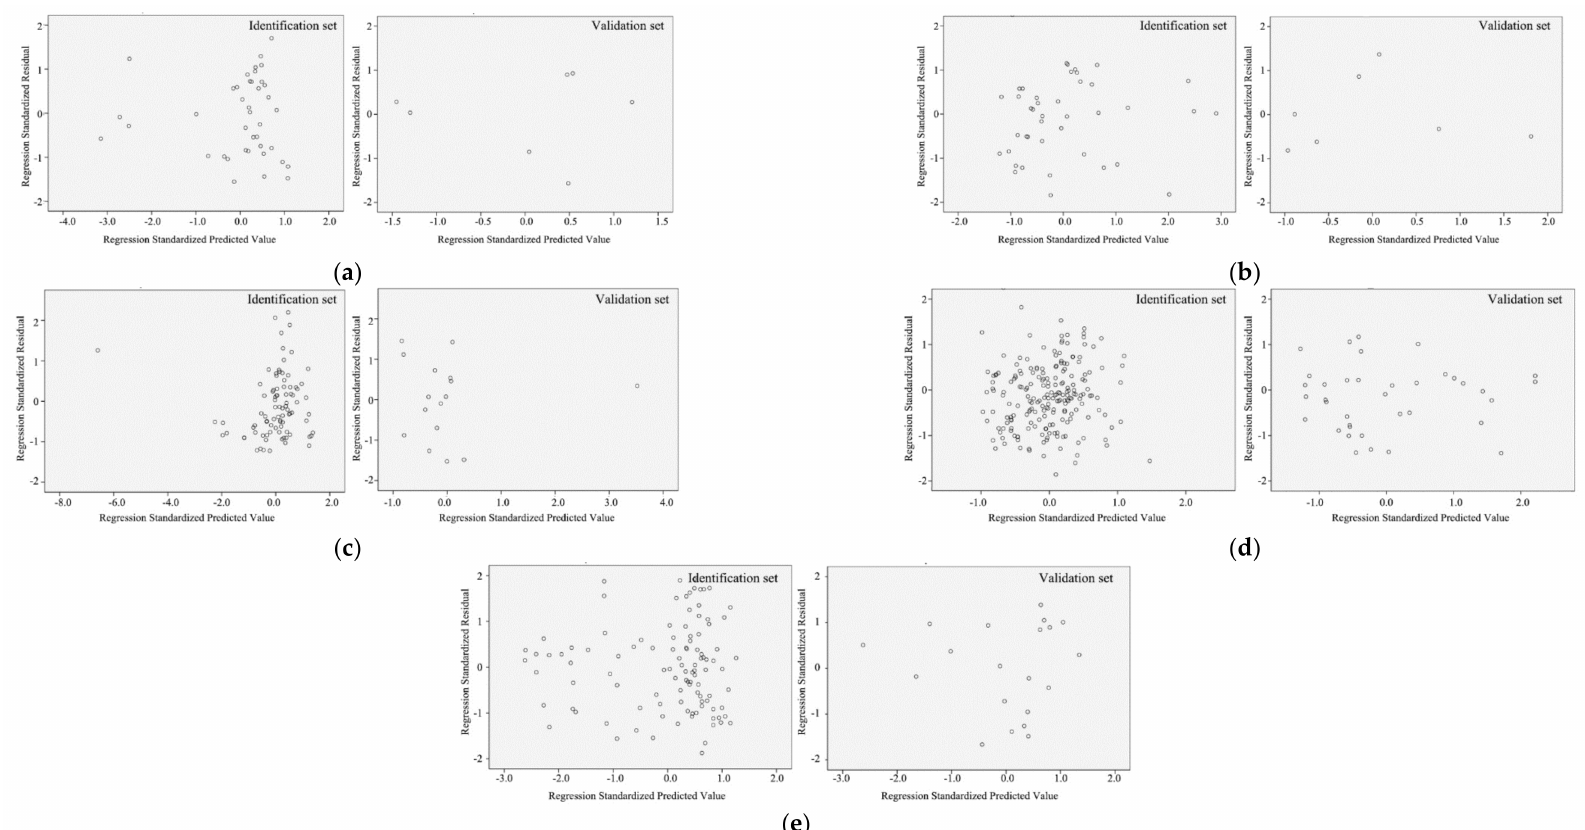
Figure 6. Regression standardized residual for urban morphology models: ( a ) hotel; ( b ) retail building; ( c ) educational building; ( d ) residential building; ( e ) o ffi